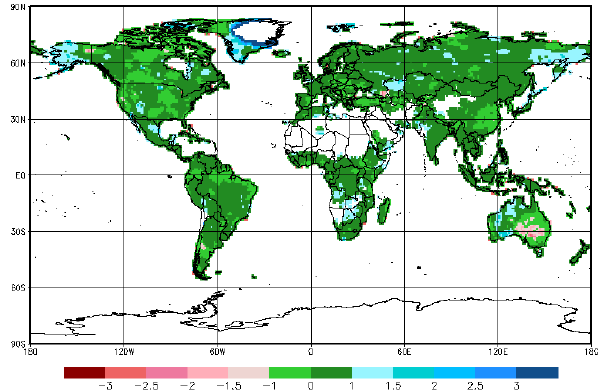
Figure 5. The SPI-DWD for January 2014 with 6-month accumu- lation interval. The color scale is the same as in Fig.